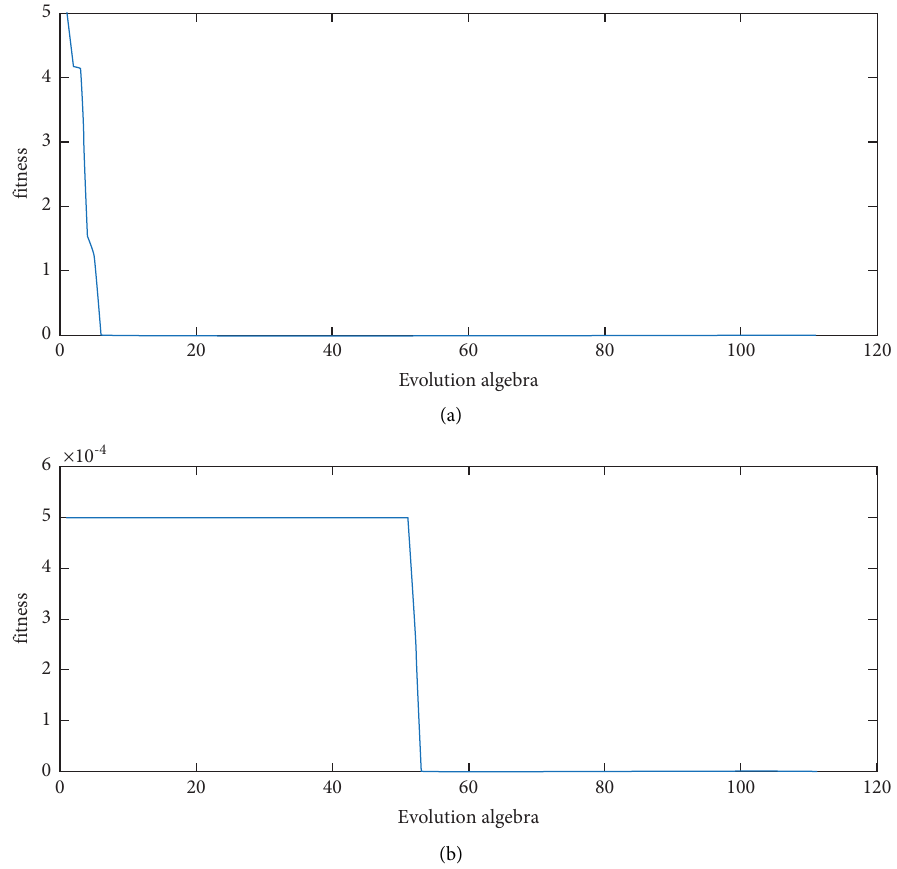
Figure 3: The experimental results of iteration. (a) PSO running effect. (b) DPMPSO running